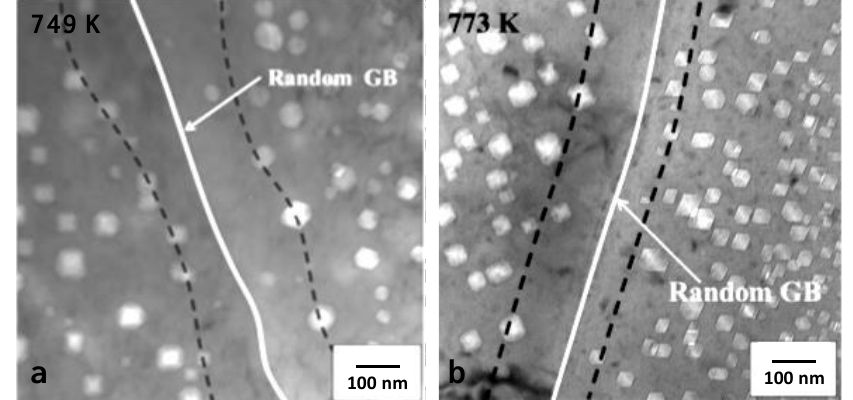
Figure 12. ( a ) Void distributions near the random GB in the Fe–15Cr–15Ni steel neutronn-irradiated in a fast reactor at 749 K to 18 dpa; ( b ) void distributions near the GB in the Fe–15Cr–15Ni steel electron-irradiated at 773 K up to 10.8 dpa. Modified from